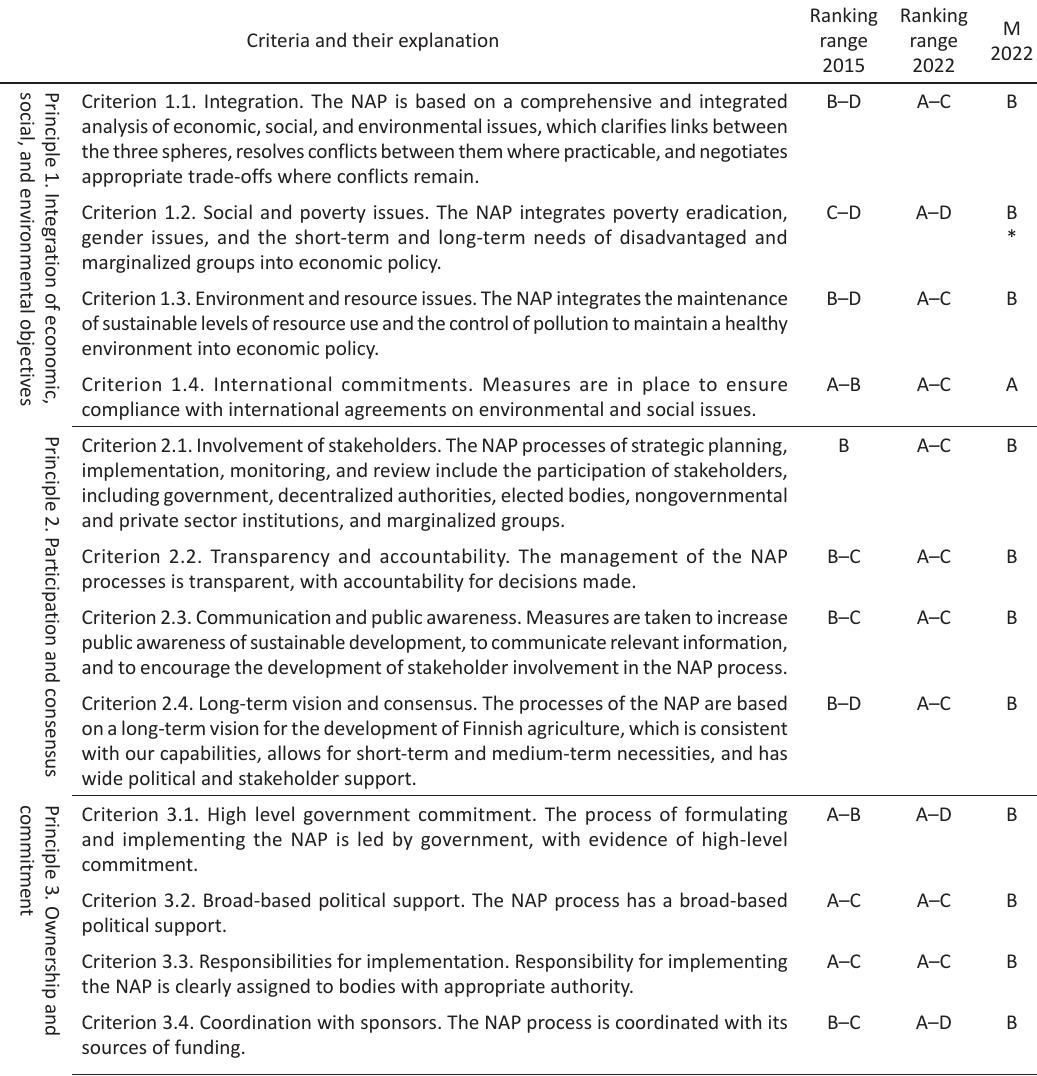
Table 2. Assessment of the experts on the Finnish progress in the implementation of the NAP in light of sustainability screening framework in 2015 and 2022. Qualitative rankings: A = all criteria fully met, B = all the requirements are satisfactorily met, although some improvements are desirable, C = some requirements satisfactorily met, but others have not met yet, D = few criteria met yet. M 2022 = Most typical (mode) ranking among the experts in the 2022 assessment. * = M 2022 is higher than the highest ranking given in